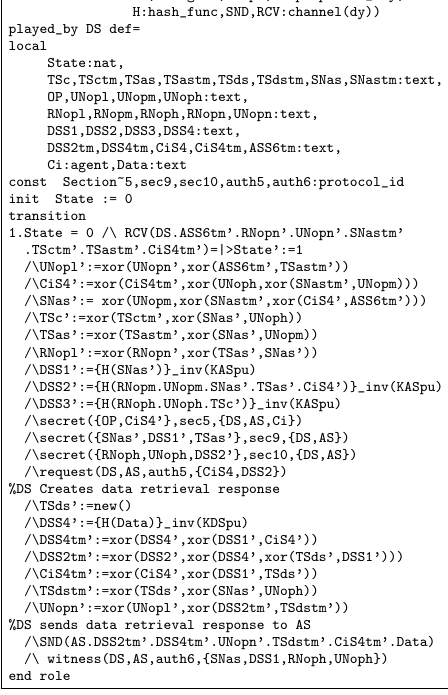
Figure A3. AS role of PAX in HLPSL. Figure A4. DS role of PAX in HLPSL. Figure A4. DS role of PAX in HLPSL.